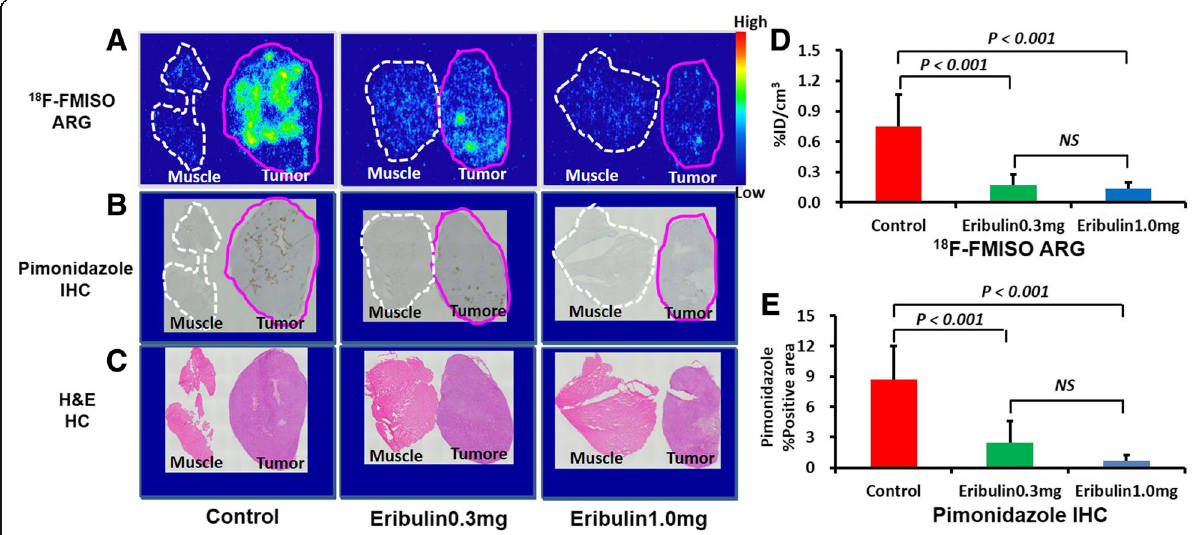
Fig. 3 Representative images of 18 F-FMISO ARG ( a ), pimonidazole IHC ( b ), H&E staining ( c ), quantitative analysis of intratumoral 18 F-FMISO accumulation level ( d ), and %pimonidazole-positive area ( e ) in the ex vivo study groups